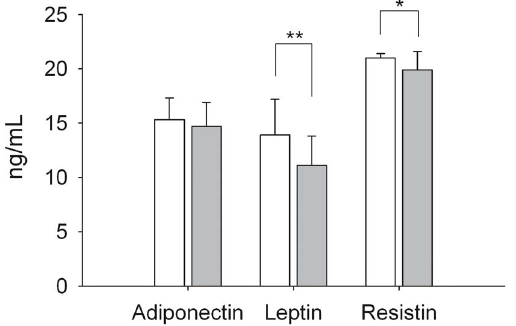
Figure 1. Serum adipokine concentrations. Concentration of adiponectin, leptin, and resistin in serum of Fischer rats after 10 weeks of intervention with control juice (white bars) or ARJ (grey bars; n=24/ group).